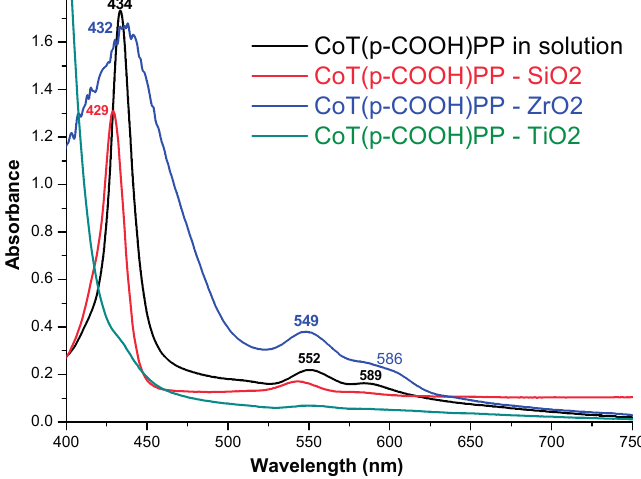
Figure 10. UV-Vis spectra of CoT( p- COOH)PP species in solution or when chemically bonded to SiO 2 , ZrO 2 and TiO 2 pore